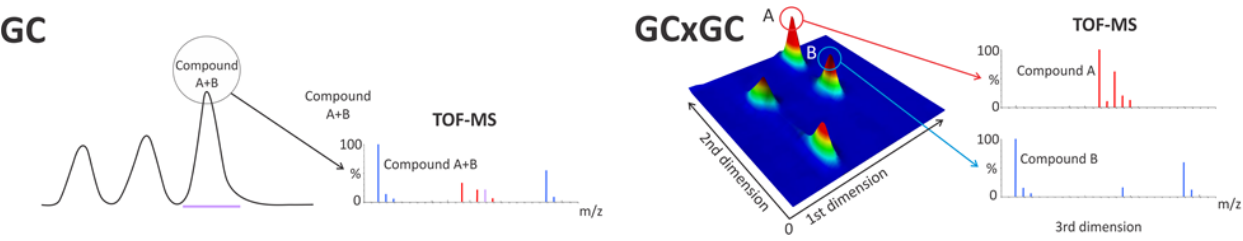
Figure 1. GC separation compared to comprehensive GC × GC separation (Röhler et al.,